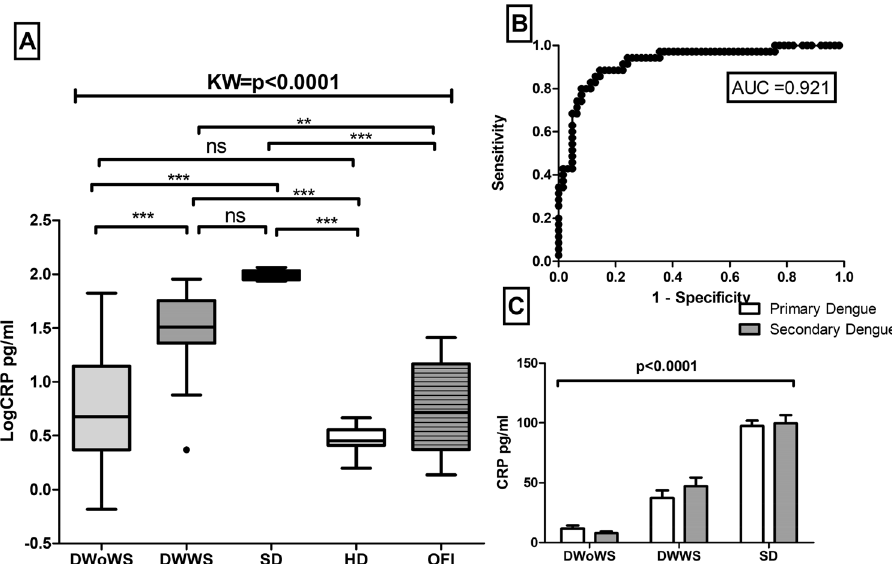
Figure 2. ( A ) Levels of C Reactive Protein (CRP) of dengue without warning sign (DWoWS), dengue with warning signs (DWWS), severe dengue (SD) and Other febrile infection (OFI). Study subjects are significantly different from each category. ( B ) Receiver operating characteristics curve analysis obtained the AUC = 0.921. ( C ), Levels of CRP of primary and secondary dengue infection. Study subjects are significantly different from each category is indicated by P < 0.05. Statistical analysis was performed using the Graph-Pad Prism statistics software (Graph-Pad Software Inc., San Diego, CA, USA free demo version 5.04).